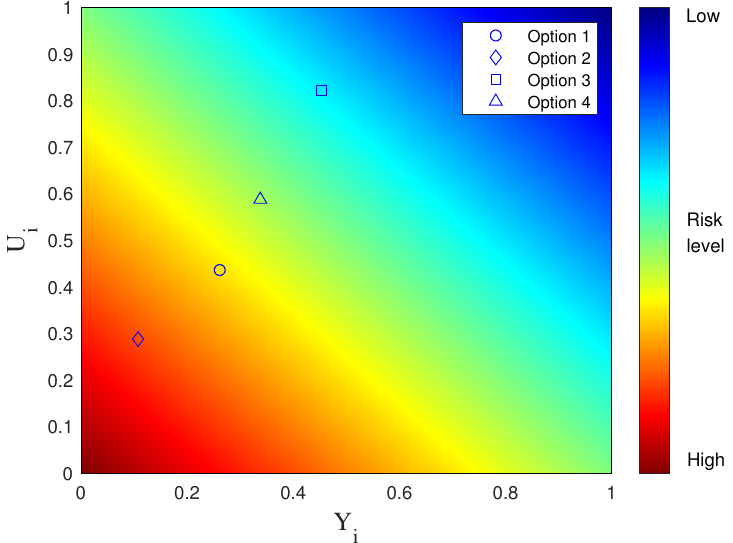
Figure 3. The risk level of each option in RSM and FMF